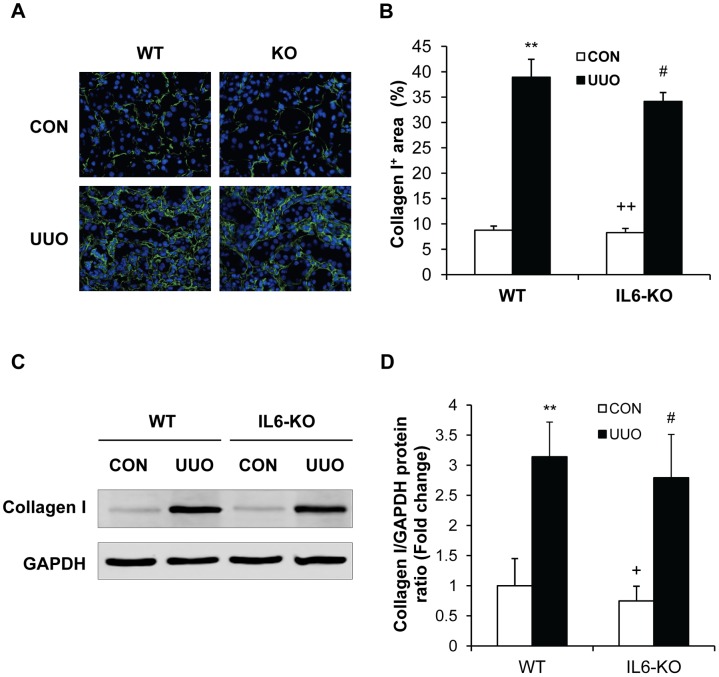
Effect of IL-6 deficiency on collagen I expression in the kidney.
A. Representative photomicrographs of collagen I immunostaining in the kidney of WT and IL-6 KO mice after surgery (original magnification X400). B. Quantitative analysis of interstitial collagen I protein expression in the kidney sections of WT and IL-6 KO mice. ** P<0.01 vs WT-control, #
P>0.05 vs WT UUO, and ++
P<0.01 vs KO UUO. n = 5 per group. C. Representative Western blots show the protein levels of collagen I in the kidney of WT and IL-6 KO mice. D. Quantitative analysis of collagen I protein expression in the kidney of WT and IL-6 KO mice. ** P<0.01 vs WT controls, #
P>0.05 vs WT UUO, and +
P<0.05 vs KO UUO. n = 4 per group.